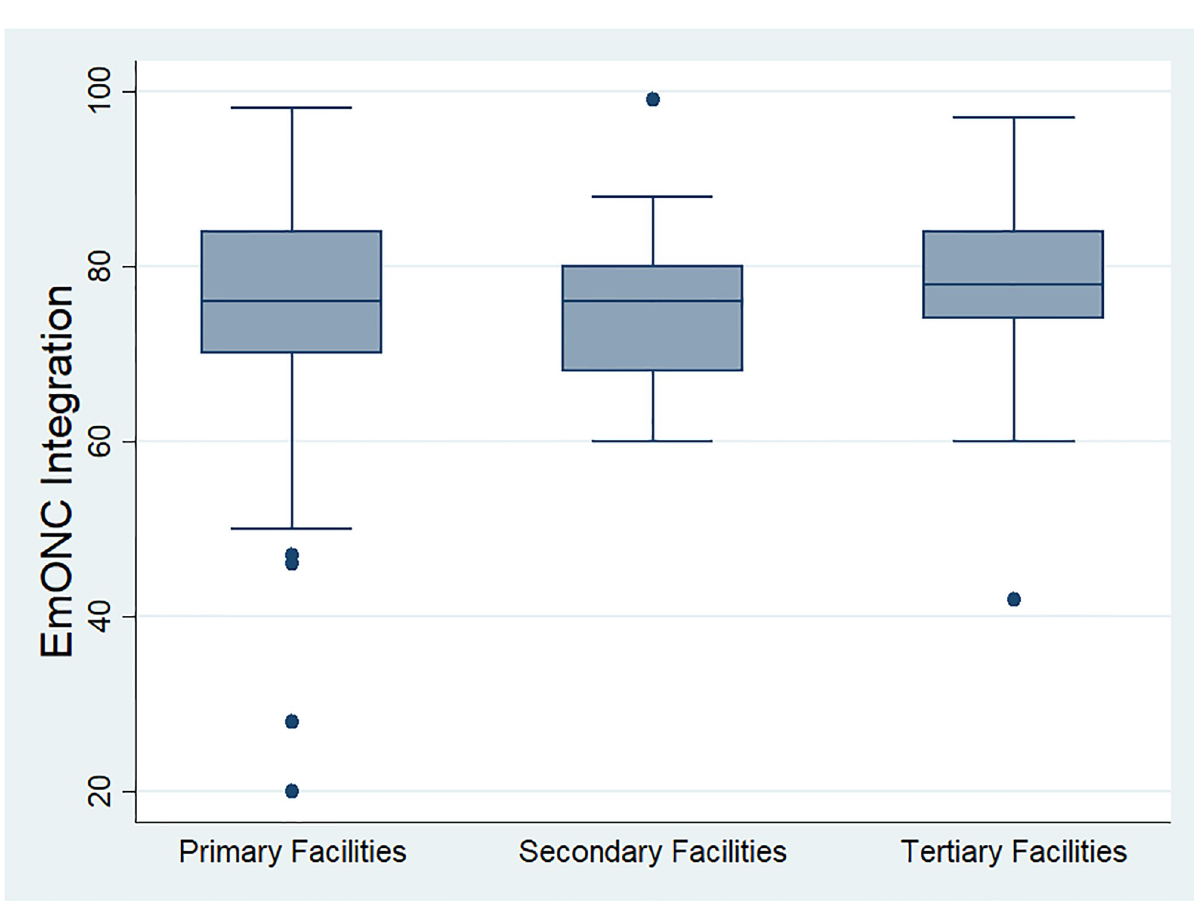
Fig 1. Integration of EmONC by the level of healthcare facility.